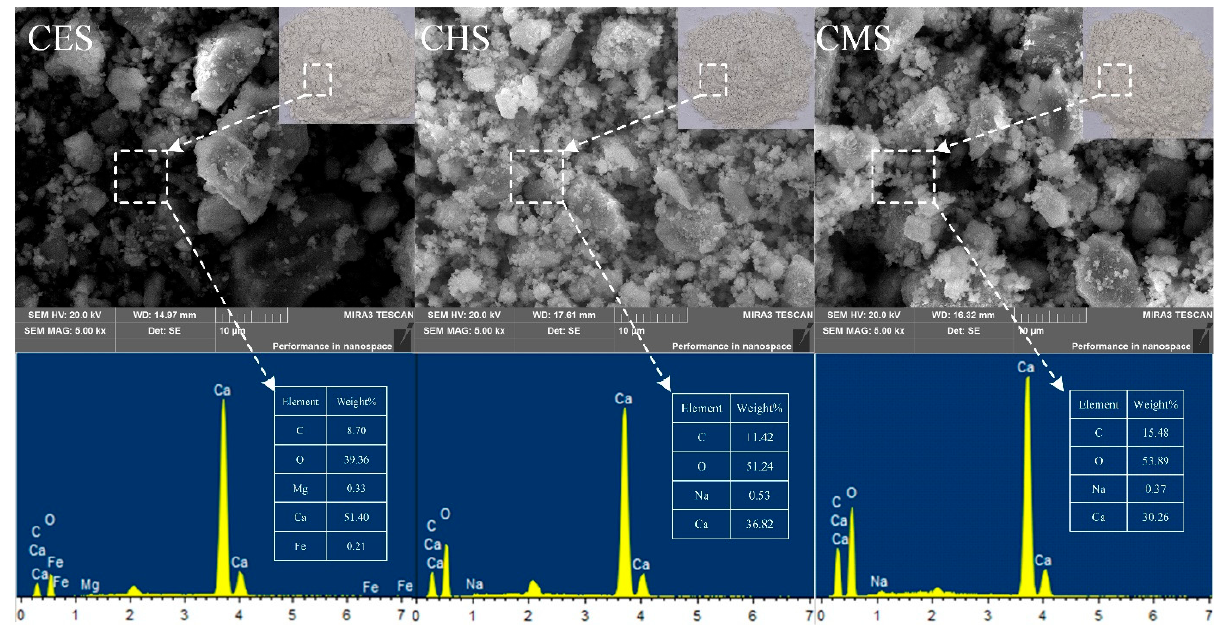
Figure 2. XRD patterns of shell bio-fillers. ( a ) CES; ( b ) CHS; ( c ) CMS.